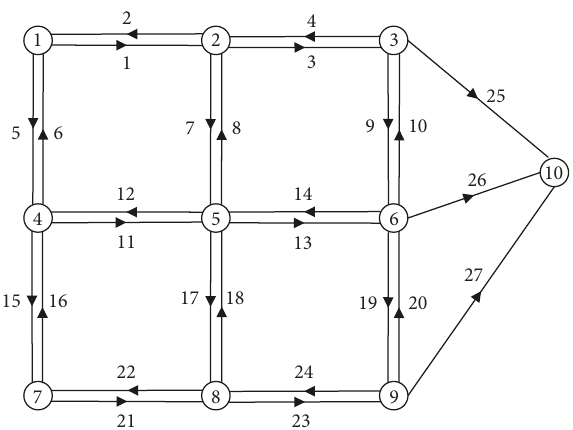
Figure 2: Topology of modified